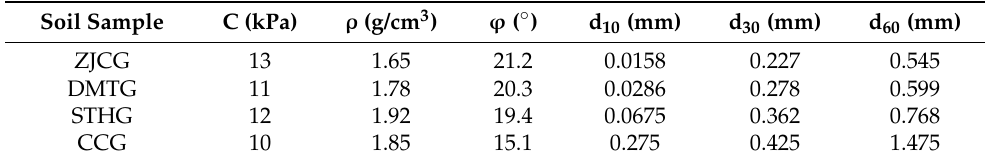
Table 4. Parameters of soil